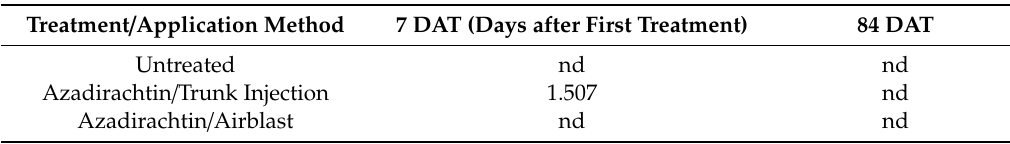
Table 3. Mean azadirachtin residue on fruit taken 7 days and 84 days after the first treatment (DAT). Residue (ppm) reported above the level of detection (0.005 ppm), or below the level of detection